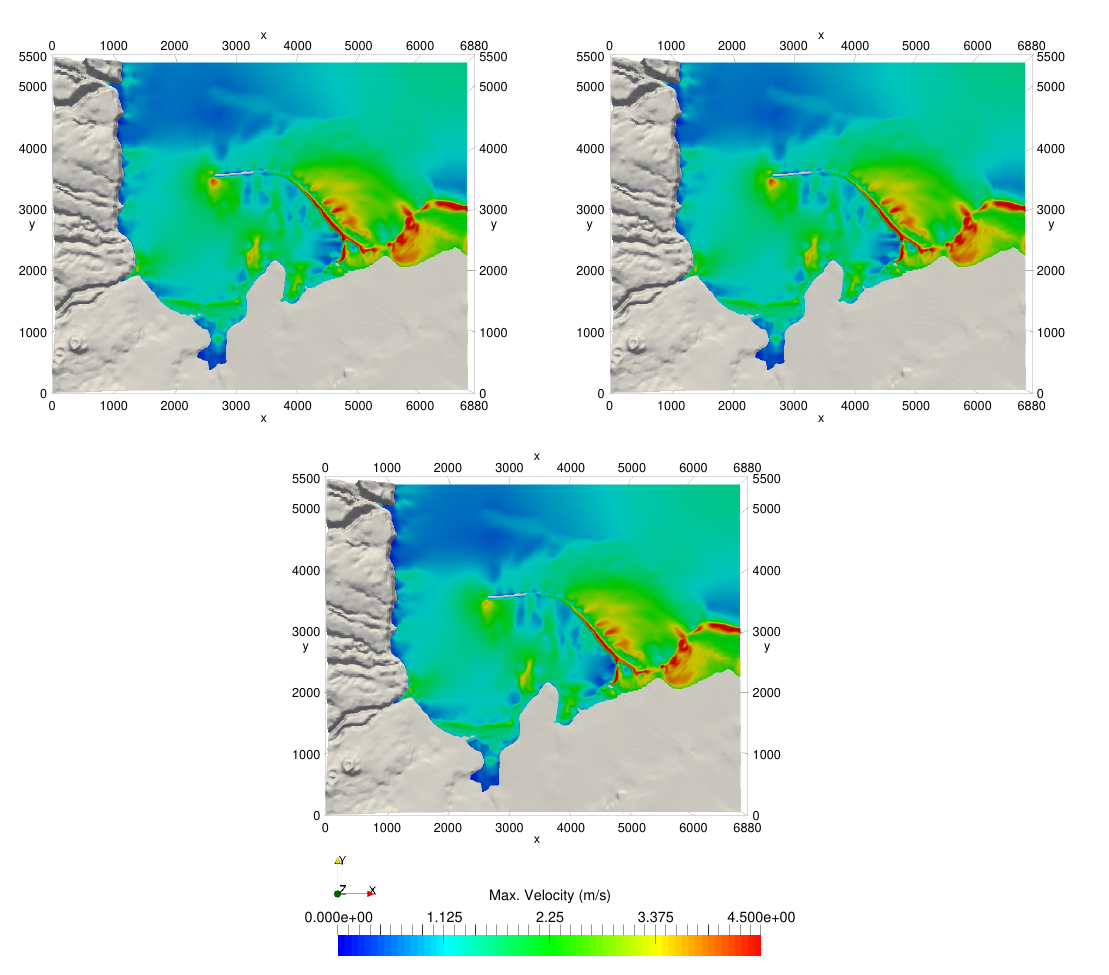
Figure 17. Case 4: numerical result for the maximum velocity captured during the 13 h simulation time using the Harten-Lax-van Leer-Contact (HLLC), Roe, and CU schemes (top left, top right,